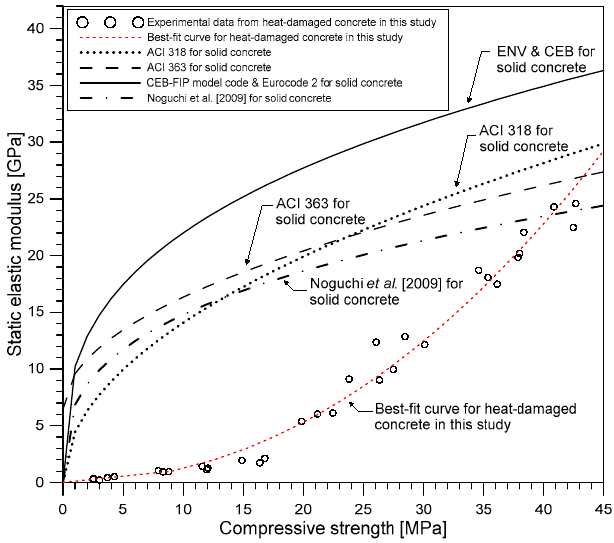
Figure 14. Relationship between the static elastic modulus and the compressive strength of heat- damaged